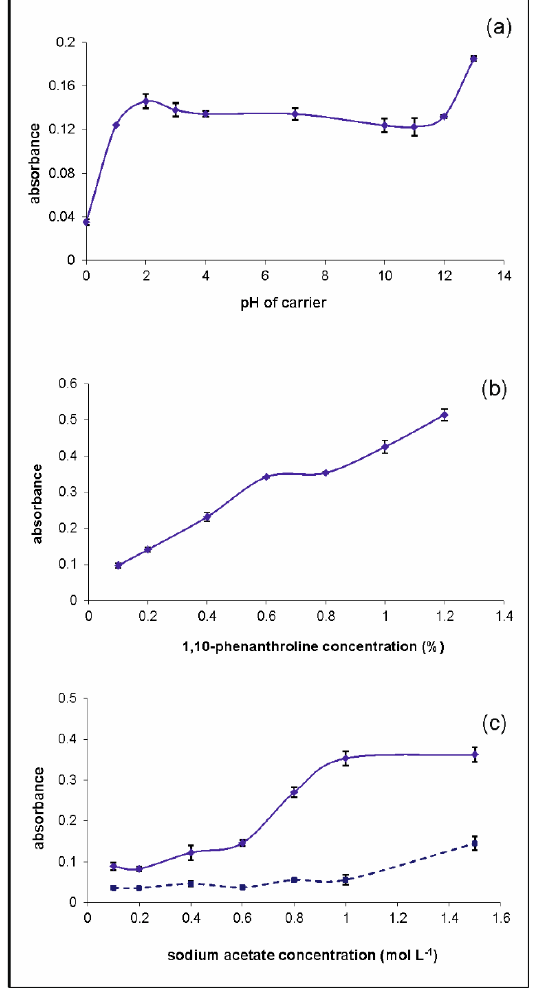
Figure 2. Effect of the most influential chemical parameters on the analytical signal. ( a ) Effect of carrier pH, ( b ) effect of 1,10-phenanthroline concentration, and ( c ) effect of sodium acetate concentration. Solid line, sample containing Fe(II) 10 mg L − 1 ; dashed line, blank. Each point represents the mean of at least four consecutive measurements, bars indicate the standard deviations.